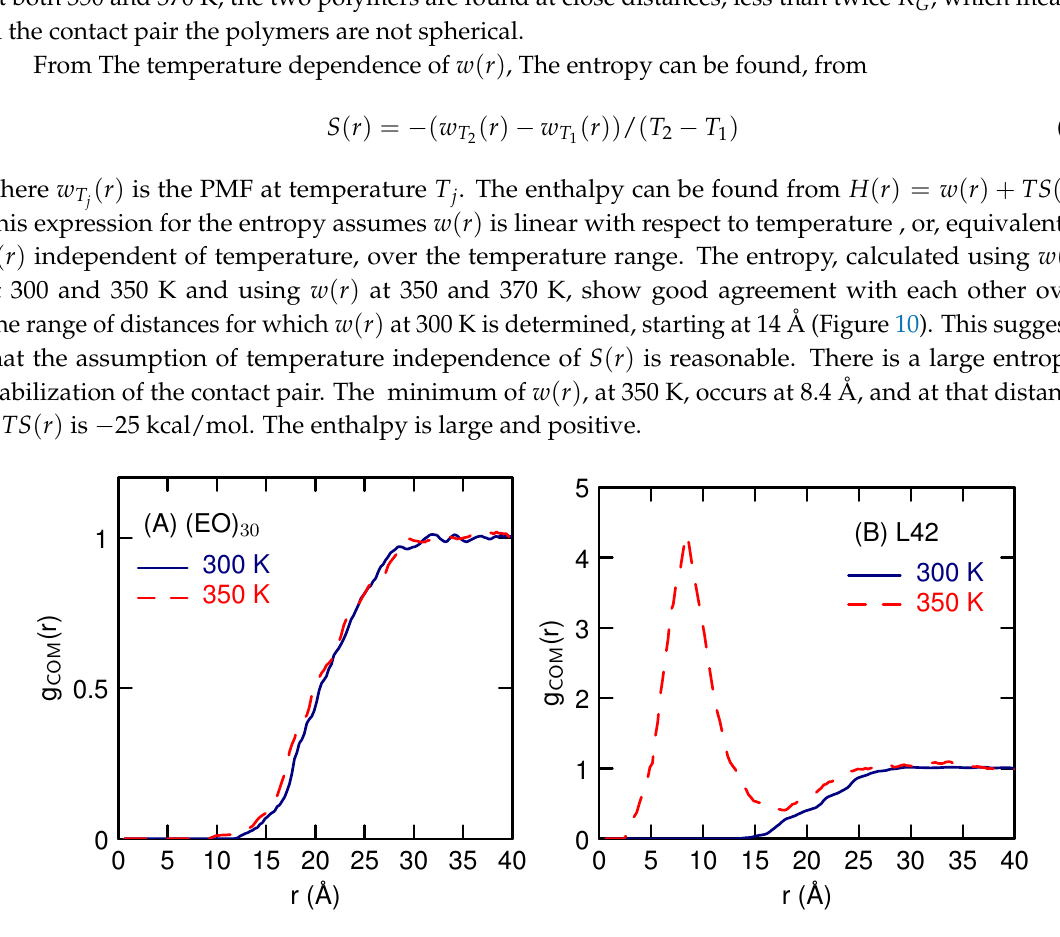
Figure 8. Radial distribution functions between the polymer centers-of-mass at different temperatures for aqueous dimers of ( A ) EO 30 and ( B )